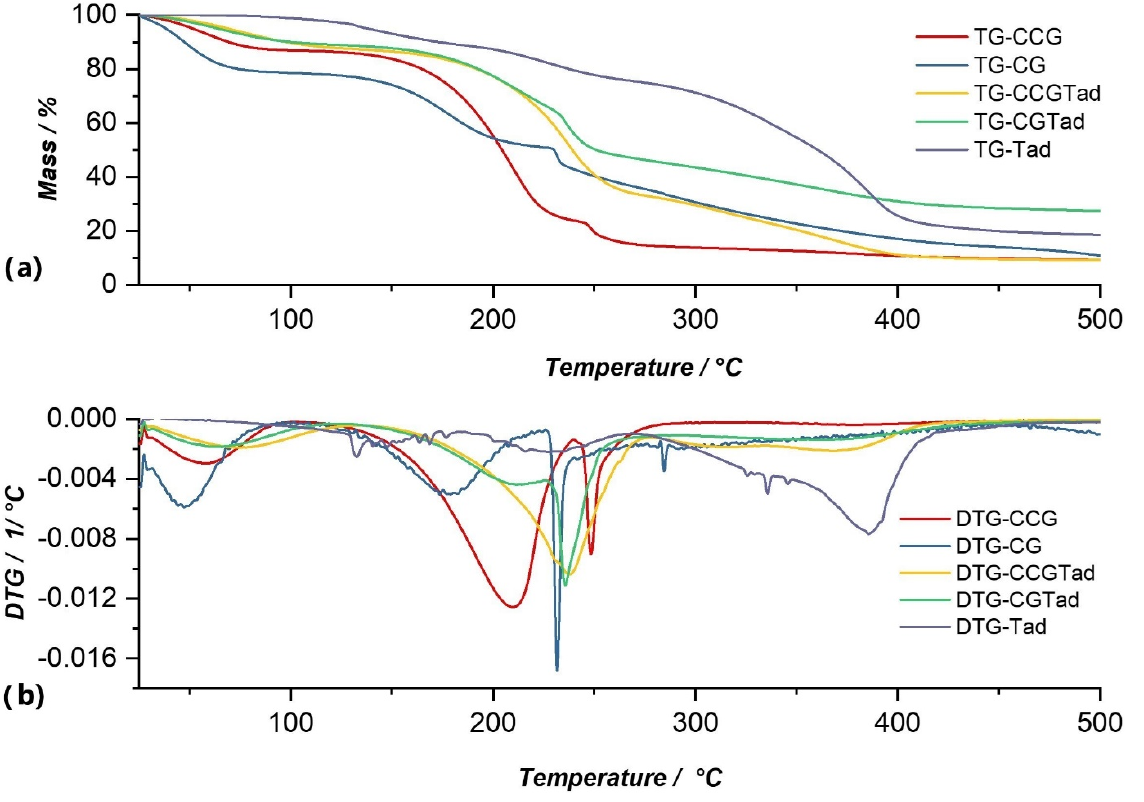
Figure 8. Comparison of TG ( a ) and DTG ( b ) curves of Tad with membranes in which this substance was incorporated (CCGTad, CGTad), as well as with control membranes (CCG and CG).